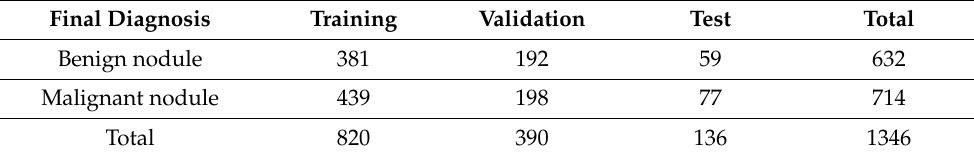
Table 3. The number of lung nodules included in each dataset used for the CADx